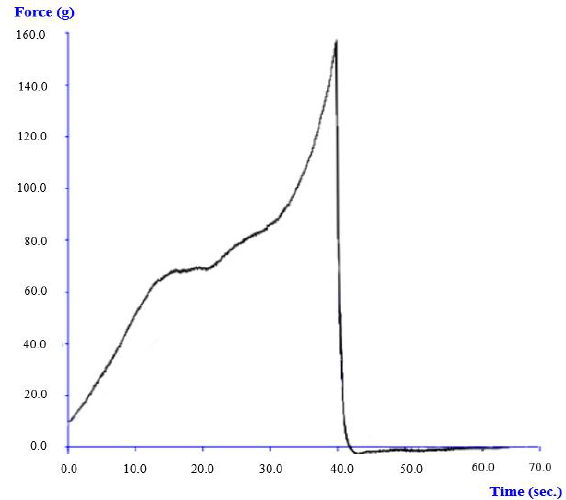
Figure 4. Force penetration curve for SW gel at 10% protein concentration ( n = 3).